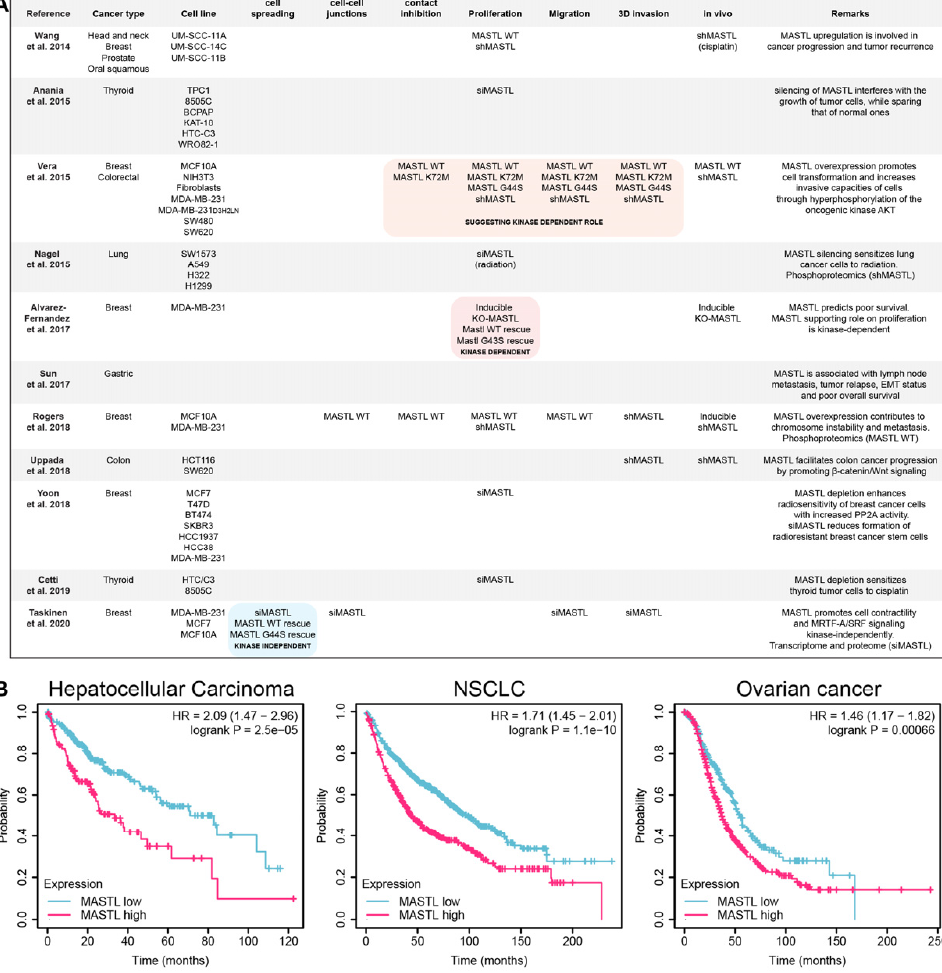
Figure 3. MASTL in cancer. ( A ) Literature describing MASTL function in various cancer types. Thefunctionalexperiments(MASTLWT:overexpressionofthewildtype, MASTLK72M:overexpression of the hyperactive kinase, MASTL G44S(human) / G43S(murine): overexpression of kinase dead, siMASTL: small interfering RNA-based silencing, shMASTL: short hairpin RNA-based silencing) in relation to cell spreading, cell–cell junctions, contact inhibition, proliferation, migration, 3D invasion, and in vivo experiments are indicated. The kinase-independent (blue) and kinase-dependent (red) functions are highlighted. ( B ) MASTL expression survival analysis from RNA sequencing datasets, where plots show overall survival in hepatocellular carcinoma, non-small-cell lung cancer (NSCLC) and ovarian cancer in MASTL high or low expressing patients. Kaplan–Meier plots were generated using KMPlot (URL: http: // kmplot.com;